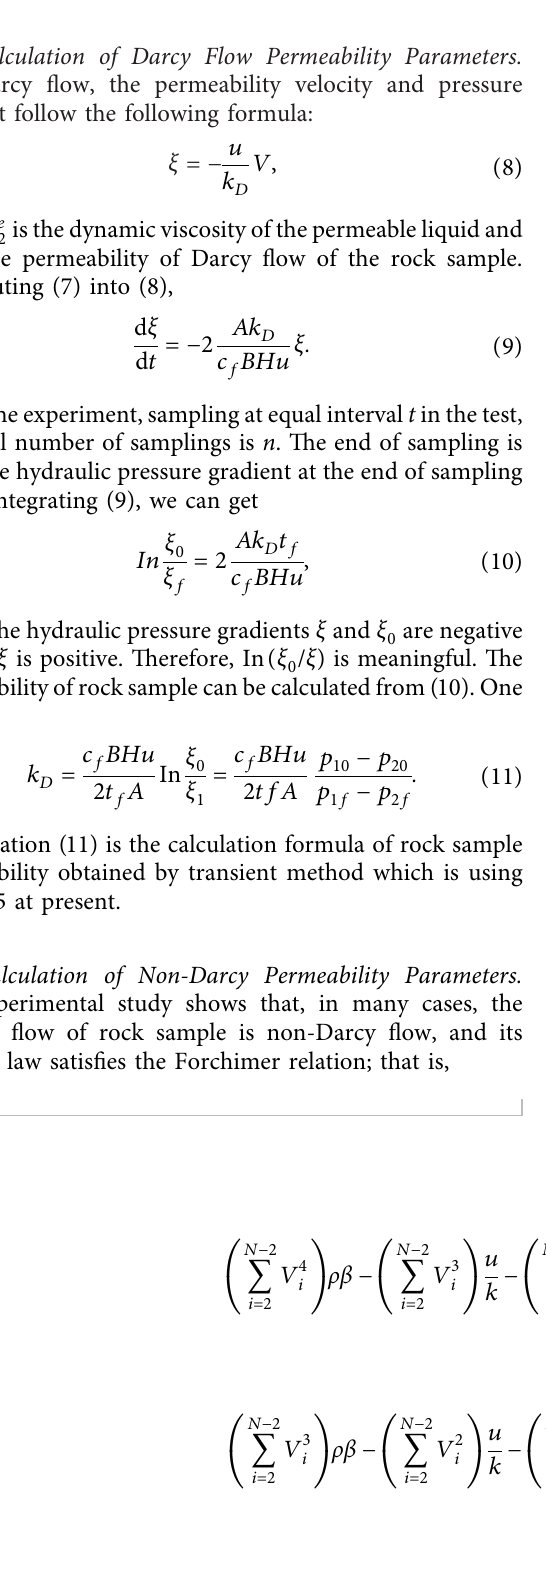
Figure 5: Principle of the transient permeation test